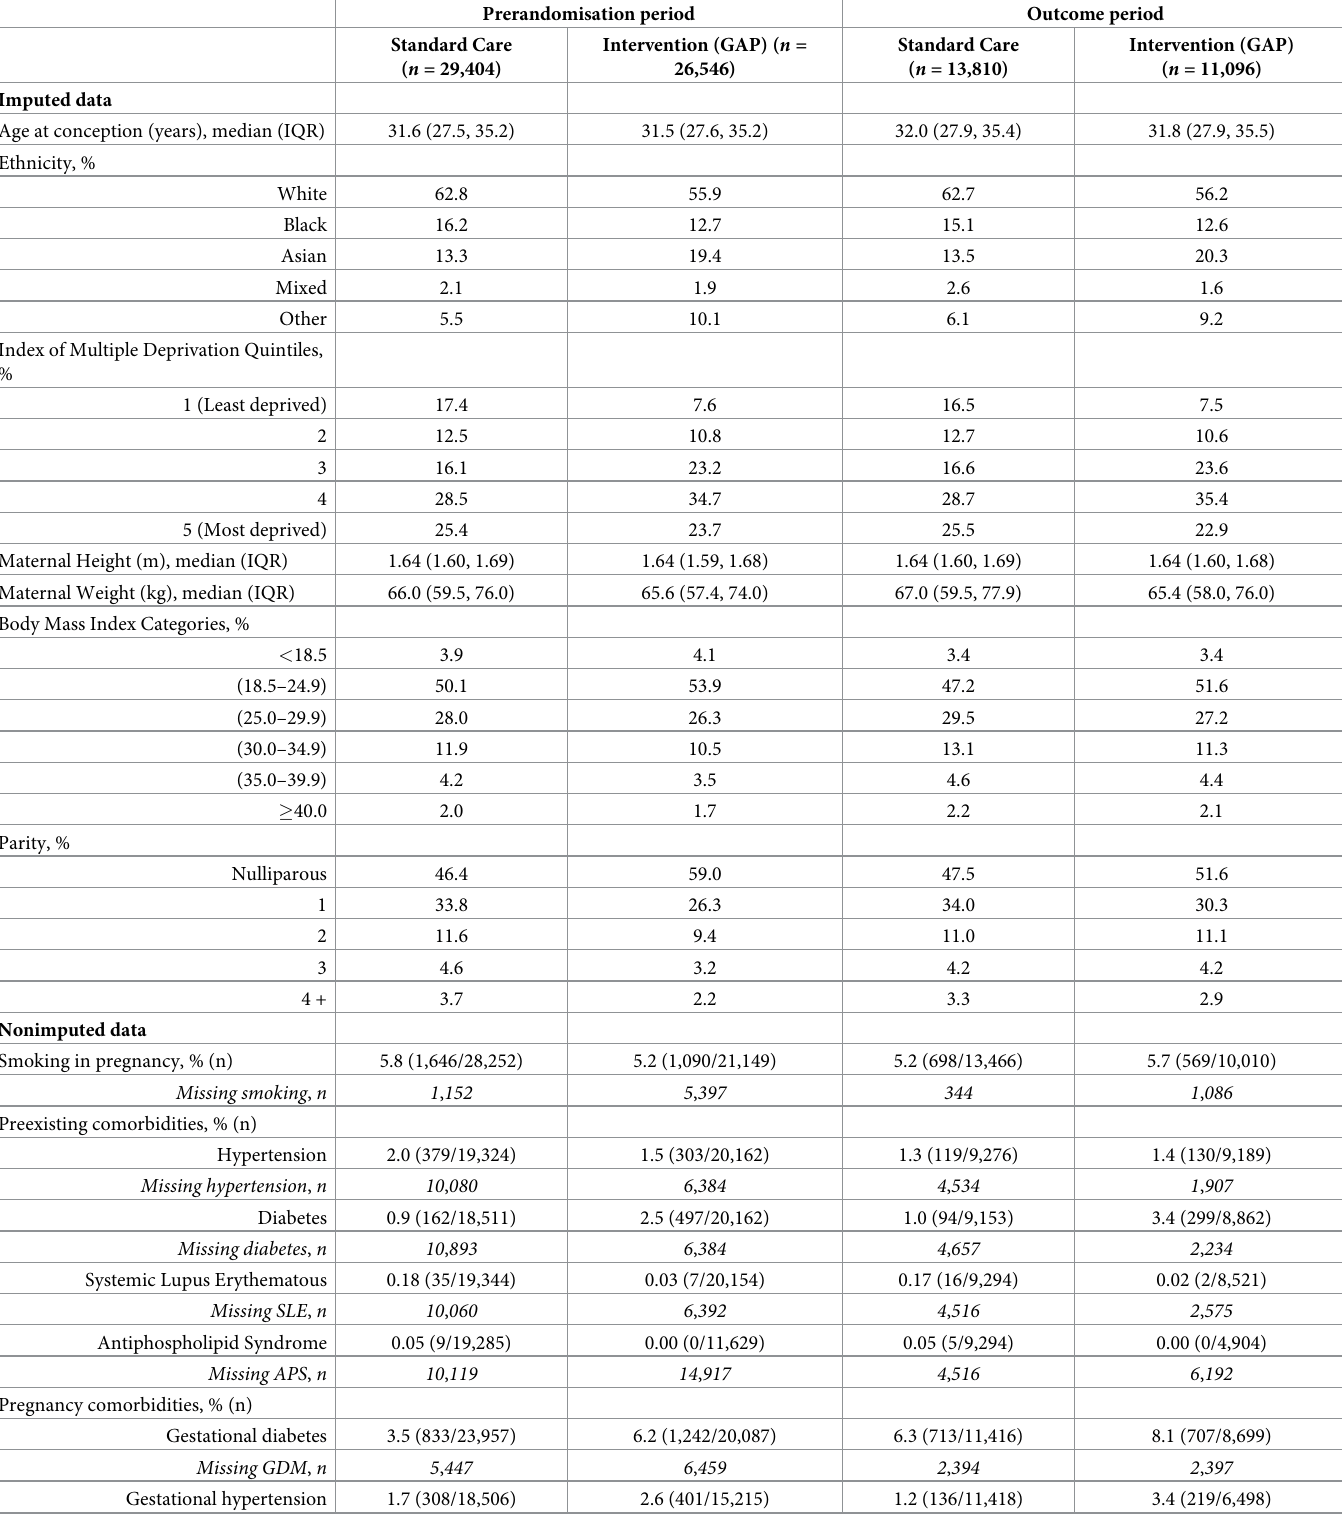
Table 2. Clinical and sociodemographic characteristics according to treatment allocation (modified intention to treat